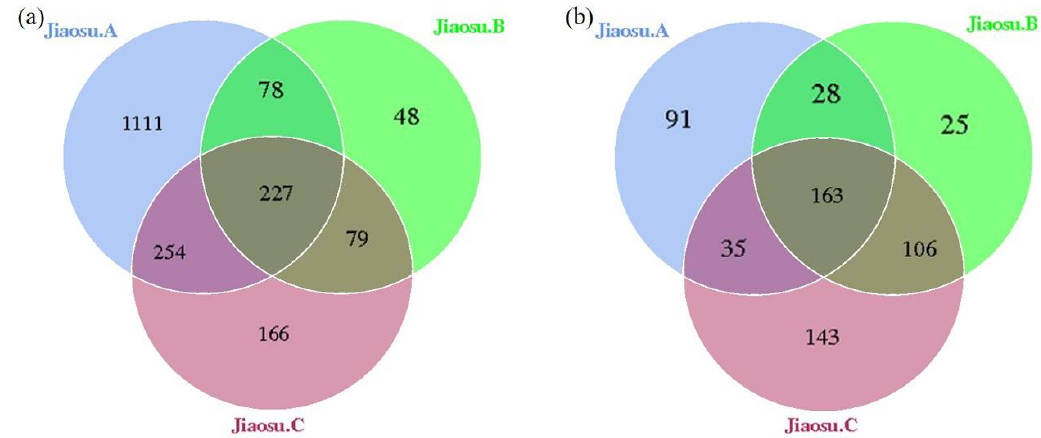
Figure 1. Venn plot of bacterial ( a ) and fungal ( b ) operational taxonomic units (OTUs) in all samples.